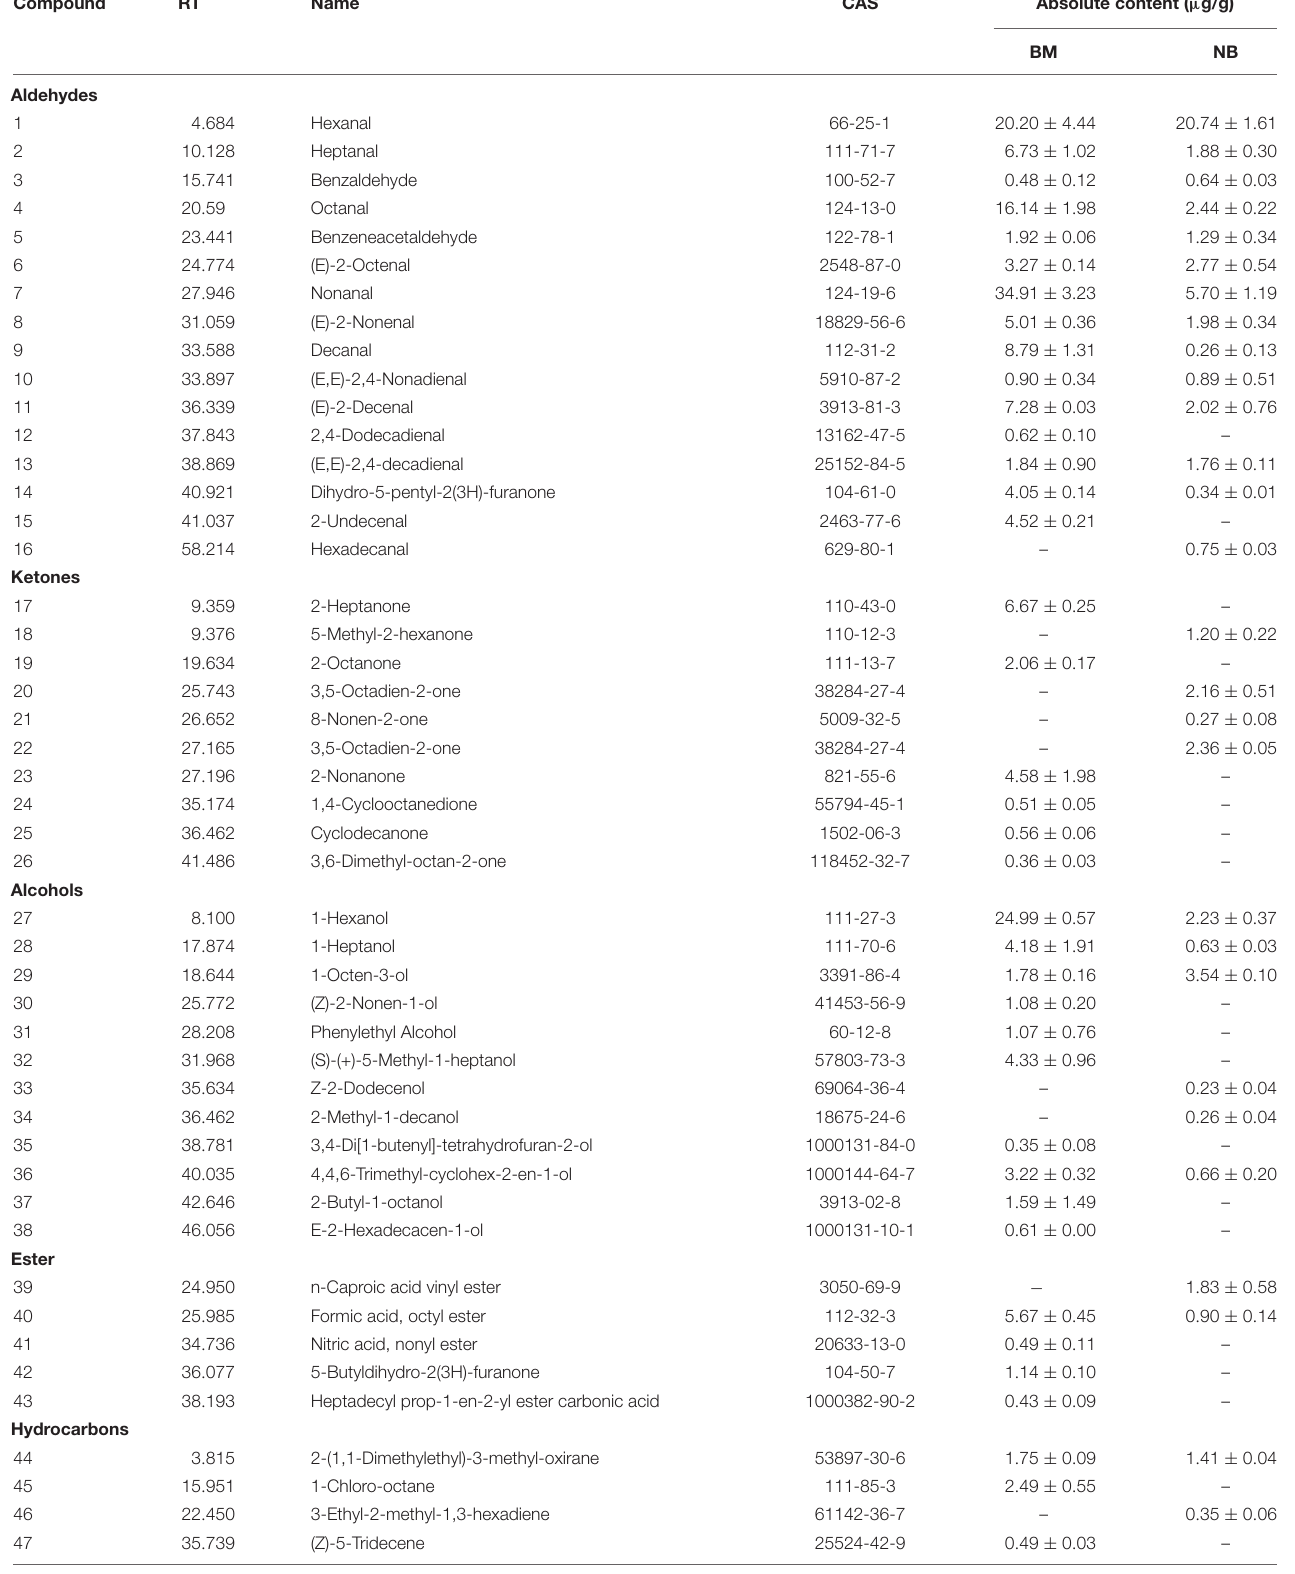
TABLE 2 | Types and contents of flavor compounds in Mianning